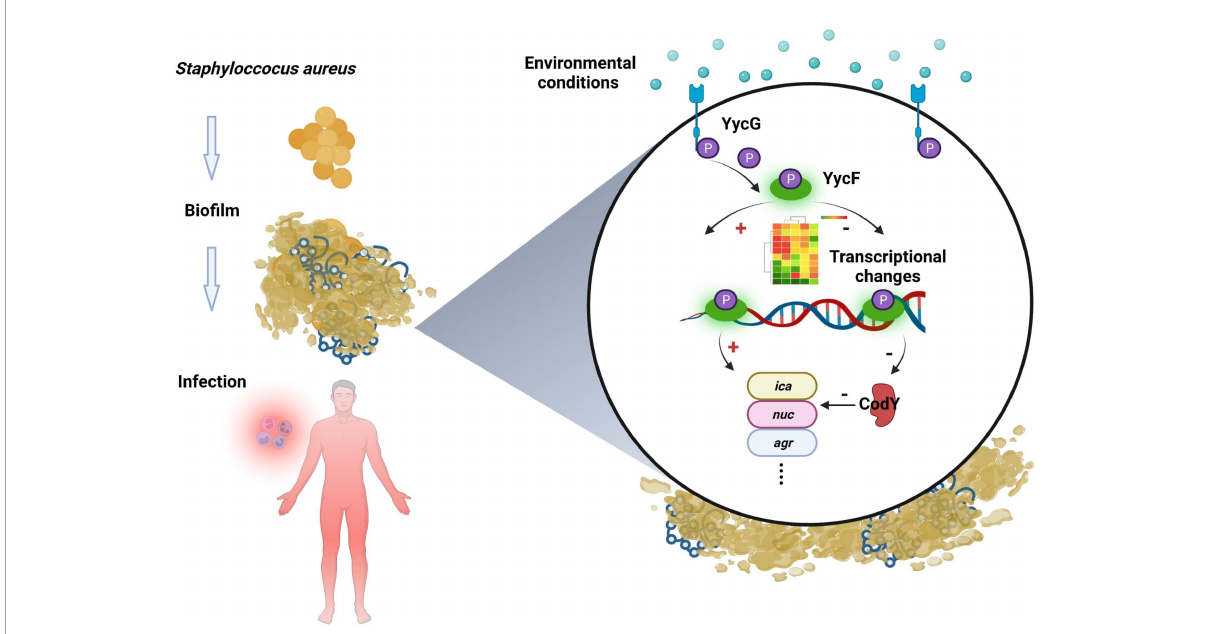
FIGURE7 Working model of CodY interactions with YycF affects biofilm formation in Staphylococcus